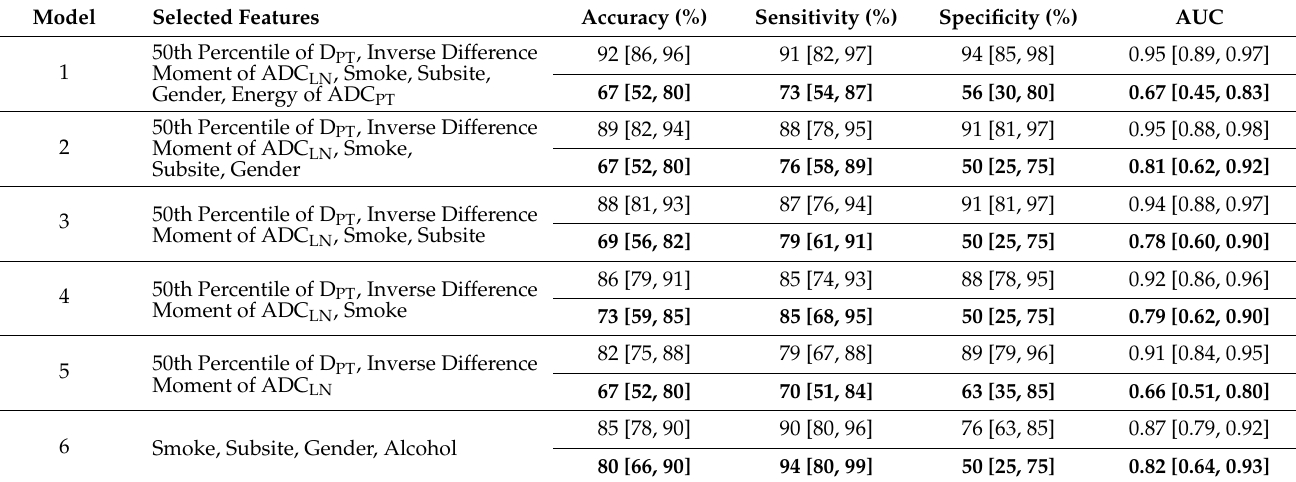
Table 3. Predictive performance of the proposed models on the training cohort and validation cohort ( in bold